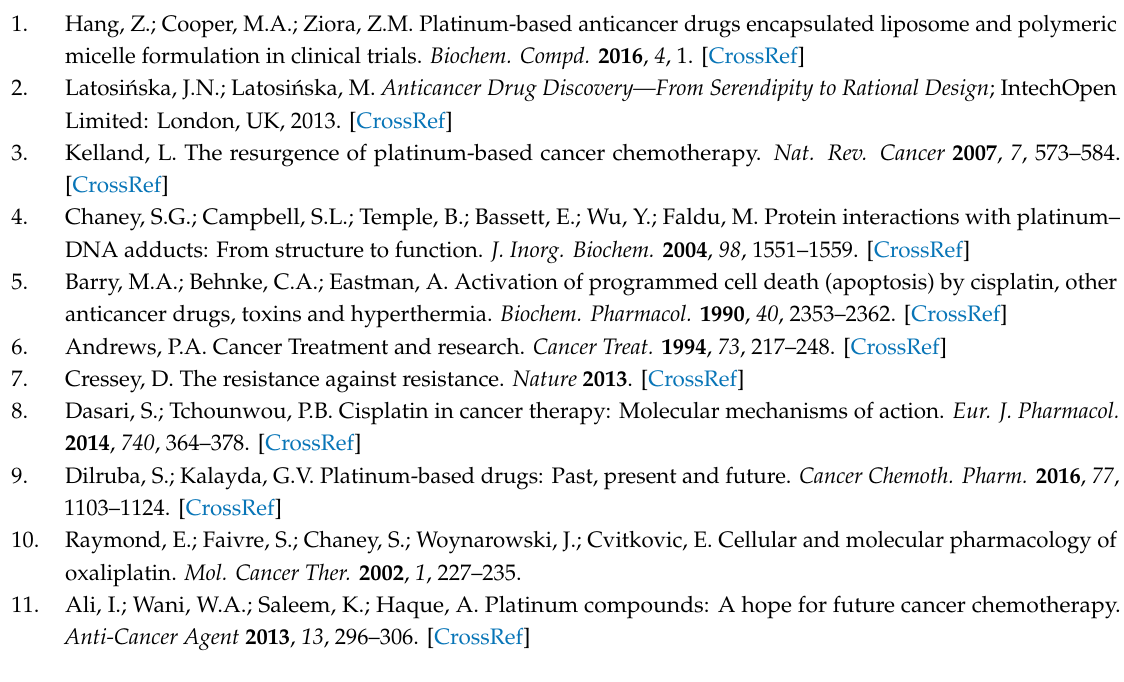
Figure S1. Calibration curve of ND showing a linear response in the range of 100–700 ng / mL with a correlation coe ffi cient of 1. Figure S2. Evaluating cytotoxicity of free and liposomal nedaplatin after 72 h of drug exposure using MTT assay in HEK293 cells. Figure S3. A dose-dependent decrease of CBPI values is noticed across increasing drug concentrations in both cell lines with A549 showing a steeper decrease and with LND yielding significantly lower CBPI values compared to ND. Figure S4. Genotoxicity of free and liposomal ND in HEK293 cells assessed through micronucleus formation induction. Fold-change in induction of micronuclei (MNi) across di ff erent concentrations compared to control MNi %. Figure S5. Quantification of γ H2AX positive (top) and γ H2AX panuclear (bottom) HEK293 cells treated with ND and LND. Multiple pair-wise t -tests showed the concentrations of treatment where a significant di ff erence between LND and ND DNA damage is observed. These points are indicated by asterisks * in the charts above. Figure S6. Apoptotic cell nuclear morphology in A549 following treatments for 72 h with ND or LND. Figure S7. Genotoxicity of free and liposomal ND in di ff erent cell lines assessed through micronucleus formation induction. (A) A549; (B) U2OS, (C) WI-38 and (D) HEK293 showing Micronucleus frequency per 100 binucleated cells across di ff erent drug concentrations. An overall statistically significant increase in MNi formation was observed with LND compared to ND (p-value < 0.05) in cancer cell lines A and B, but not in normal cell lines C and D. Multiple pair-wise t -tests show the concentrations at which a significant di ff erence between both drugs was observed. These points are indicated by asterisks (*). Table S1. Size statistics for non-loaded (void) liposomes. Table S2. Size statistics for nedaplatin-loaded (LND)